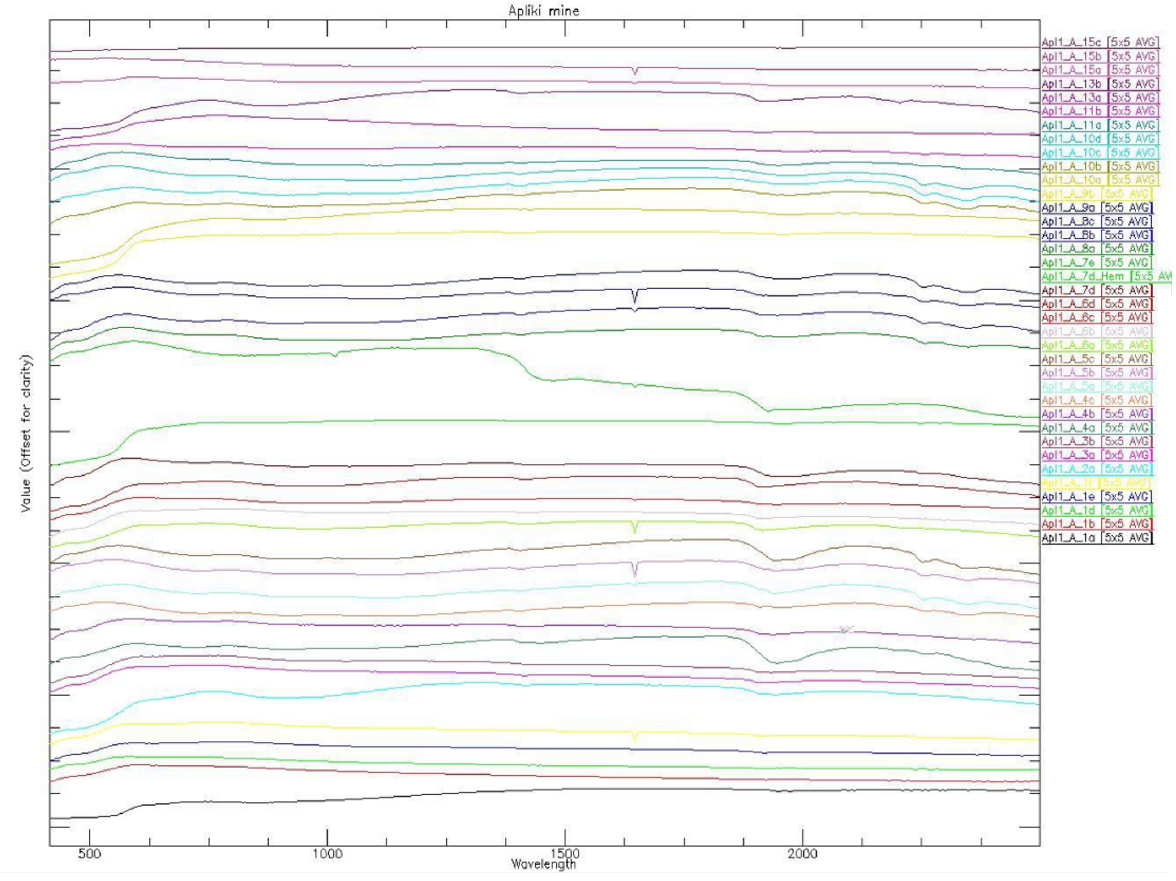
Figure 12. Spectral library of the 37 different Apliki mine samples; spectra stacked with offset.